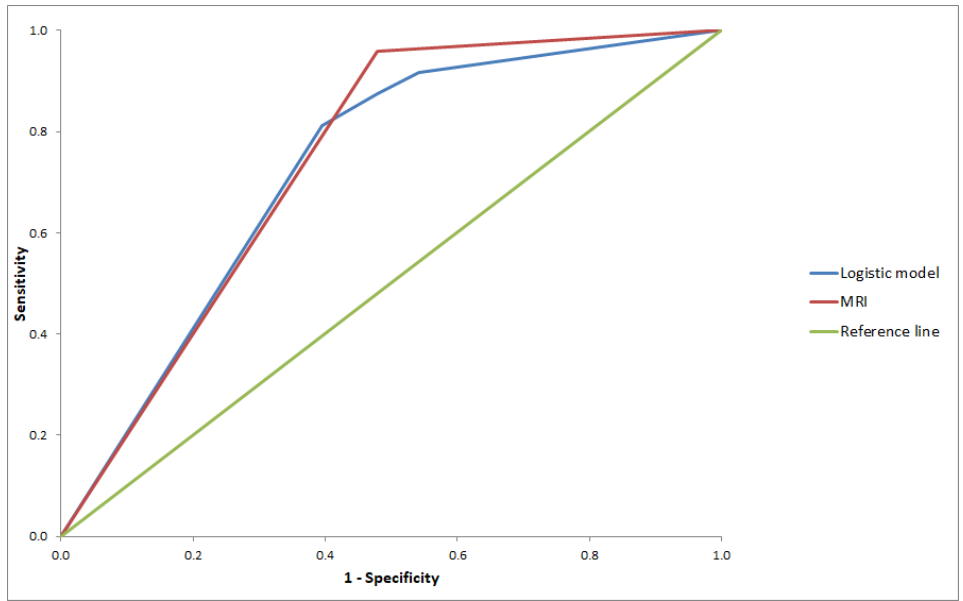
Figure 3. ROC curve describing the relation of sensitivity to specificity in the clinical tests of the logistics model and MRI for the medial meniscus.